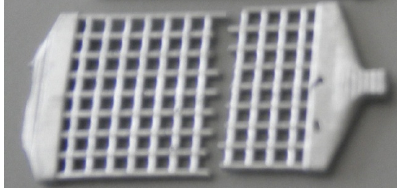
Figure 16. Microstructures of a sample with a section diameter of 0.7 mm, poured at 635 °C, in a mold temperature of 350 °C assessed in different zones: (a) Zone 1; (b) Zone 2 (c) Zone 3.